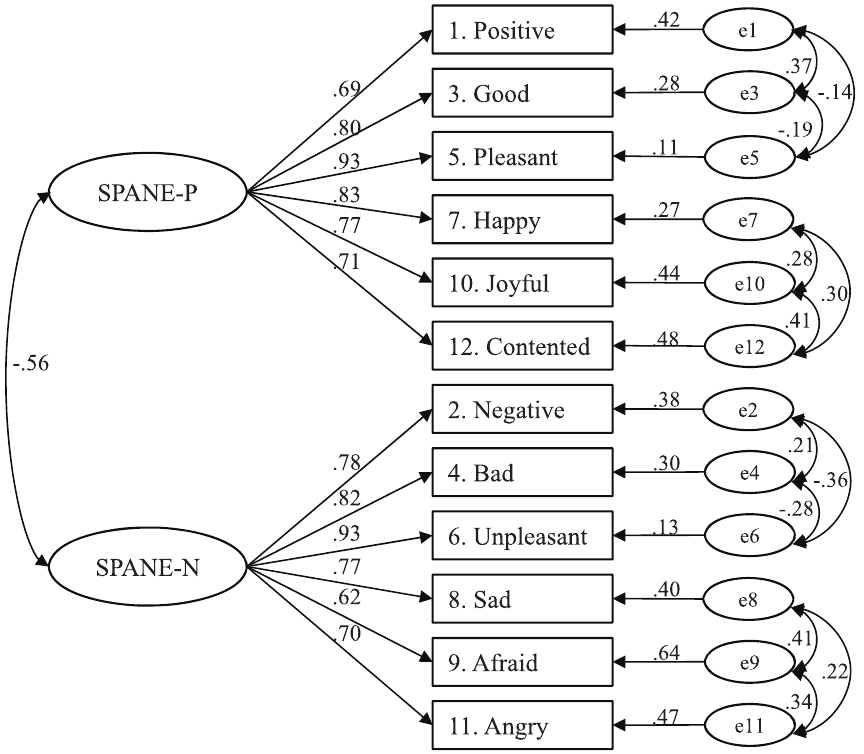
Figure 1. Graphical representation of the correlated two-factor model of the SPANE (model 2b); the factor loadings are standardized loadings.